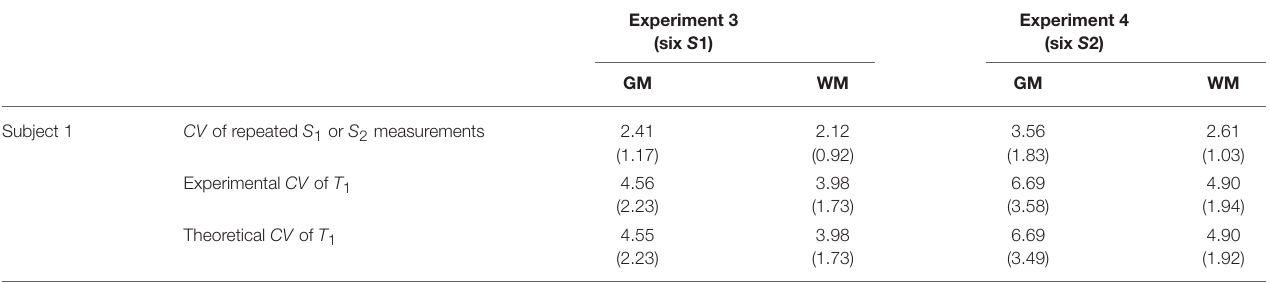
TABLE 2 | Median and IQR of CV values inside GM and WM for Experiments